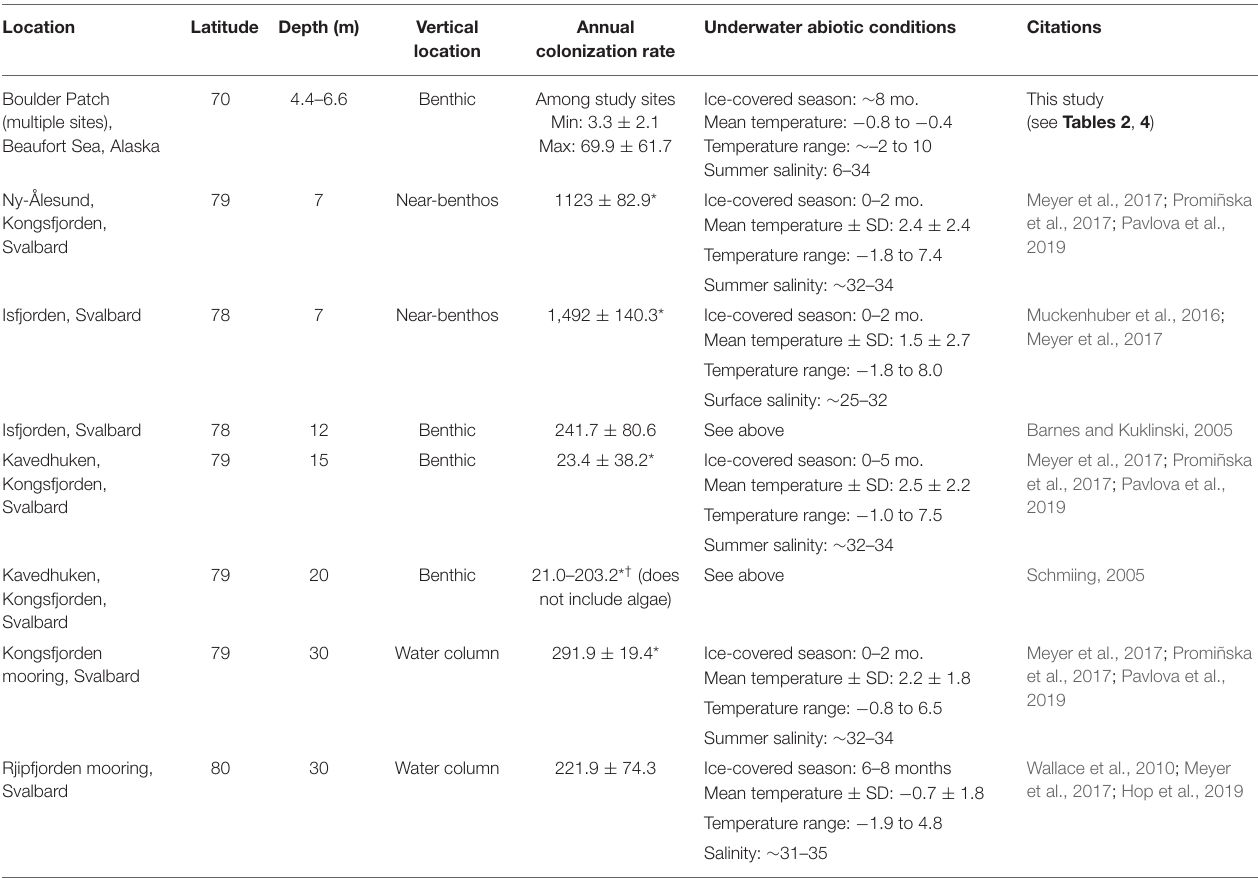
TABLE 5 | Comparison of annual colonization rates from similar studies in Arctic subtidal habitats, ordered by